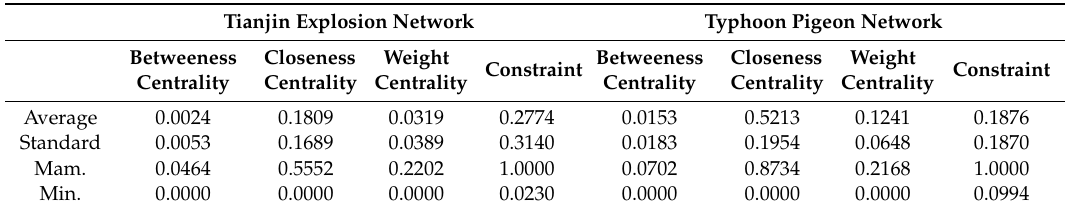
Table 1. Comparison on the Centrality and Values of the